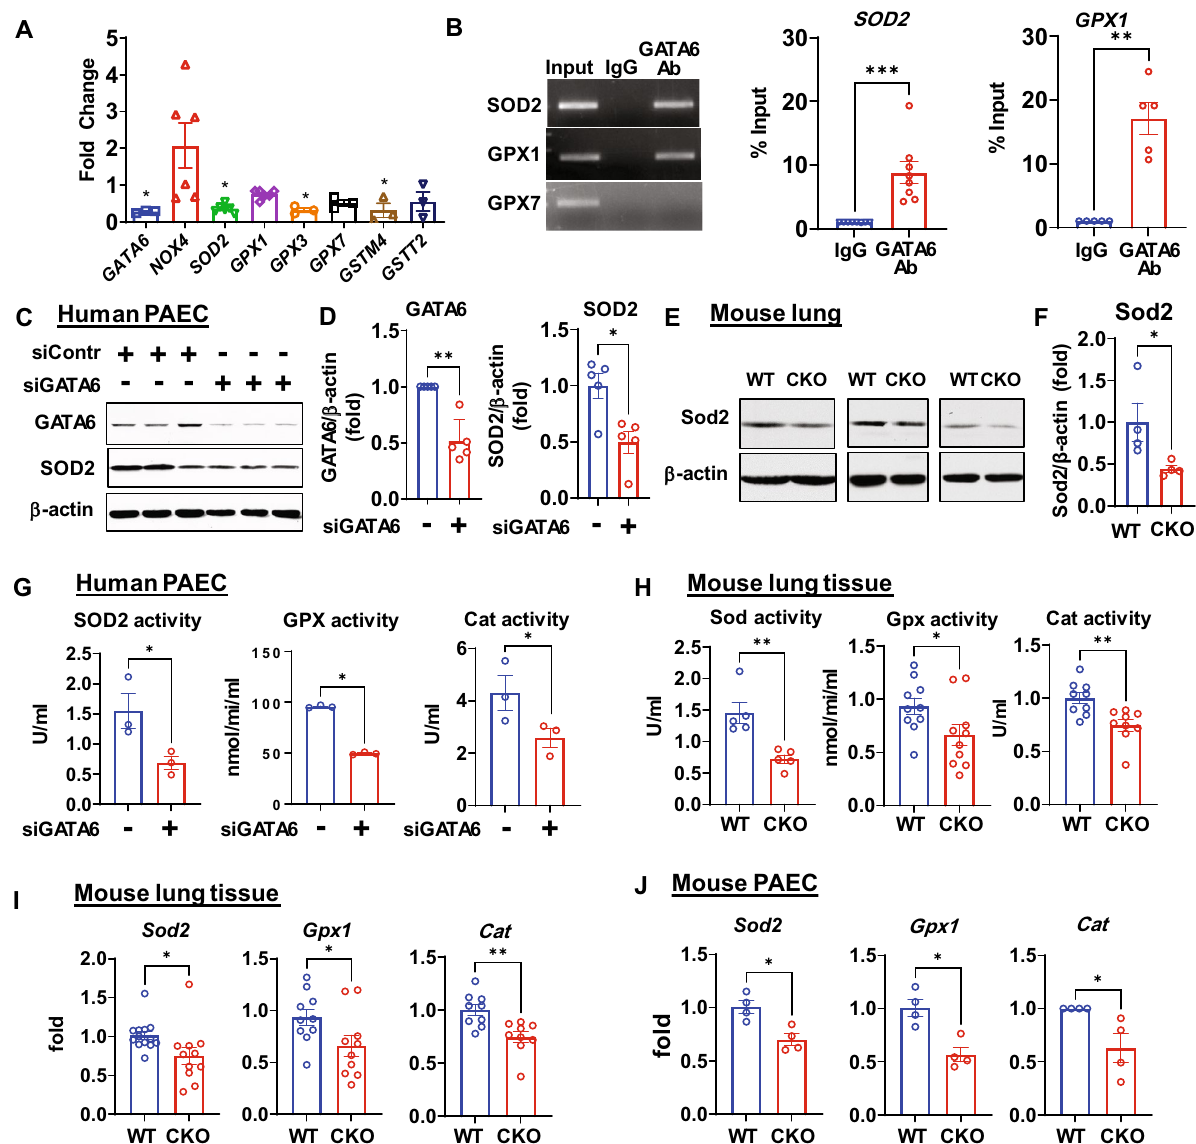
Figure 1. GATA6 loss induces SOD2 and other anti-oxidant enzymes deficiency in human and mouse PAECs. ( A ) An expression of the antioxidant enzymes measured by qPCR in human PAECs (HPAECs) transfected with siGATA6 or control scr siRNA. mRNA levels in scr siRNA transfected cells were set as one. Data are means ± SE, *p < 0.05 vs scr siRNA by Kruskal–Wallis test with post hoc Dunn’s test for multiple comparisons; n = 3–10 (see also Supplemental Table 1). ( B ) Chromatin immune precipitation (ChiP) assay in HPAECs, n = 8 for SOD2 ; n = 5 for GPX1 . The experiments were repeated three times. Representative gel images and data quantification are shown. Values are means ± SE, **p < 0.01, ***p < 0.001 by Mann Whitney U test. ( C,D ) Control HPAECs transfected with siGATA6 or scr siRNA (siContr) were assayed by Western blot analysis to detect GATA6 and SOD2. Representative blots are shown. Values are means ± SE of the relative protein levels by densitometry, n = 5, **p < 0.01 by Mann Whitney U test. ( E,F ) Western blot analysis of whole lung tissue from Gata6 CKO and WT mice. Representative blots are shown. Values are means ± SE of the relative protein levels by densitometry, n = 4, *p < 0.05 by Mann Whitney U test. ( G ) SOD2, GPX, and Catalase activity were measured in Human HPAECs transfected with siGATA6 or scr siRNA, Values are means ± SE, n = 3, *p < 0.05 by Mann Whitney U test. ( H ) Mouse Sod2 (n = 5), Gpx (n = 10), and Cat (n = 9) activity were measured in mouse lung tissue in Gata6 CKO and WT mice. *p < 0.05, **p < 0.01 by Mann Whitney U test (Sod activity) and unpaired τ test (Gpx and Cat activities). ( I,J ) mRNA levels of the antioxidant enzymes measured by qPCR in whole lung tissues ( I ) and in PAEC from Gata6 CKO mice (J). Data are means ± SE. I: n = 12–13 for Sod , n = 10/group for Gpx1 , n = 9/group for Cat . J: n = 4 mice/group. *p < 0.05, **p < 0.01 by unpaired τ test (I) or Mann Whitney U test ( J ). The original blots are presented in Supplementary Fig.